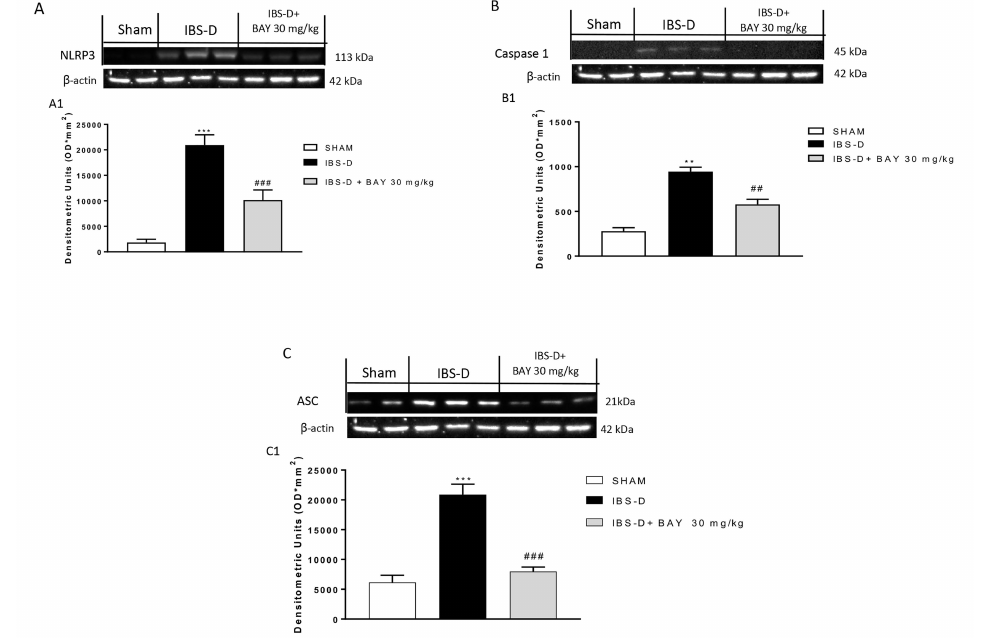
Figure 4. E ff ect of BAY 11-7082 treatment on the NLRP3 inflammasome pathway. Western blot analysis revealed an increase of NLRP3, ASC, and caspase-1 expression in the IBS-D group compared to the sham group, however the treatment with BAY at the dose of 30 mg / kg significantly reduced their expression (( A ) and densitometric analysis ( A1 ); ( B ) and densitometric analysis ( B1 ); ( C ) and densitometric analysis ( C1 ), respectively). Data are representative of at least three independent experiments. ( A ) *** p < 0.001 vs. Sham. ### p < 0.001 vs. IBS-D. ( B ) ** p < 0.01 vs. Sham. ## p < 0.01 vs. IBS-D. ( C ) *** p < 0.001 vs. Sham. ### p < 0.001 vs.